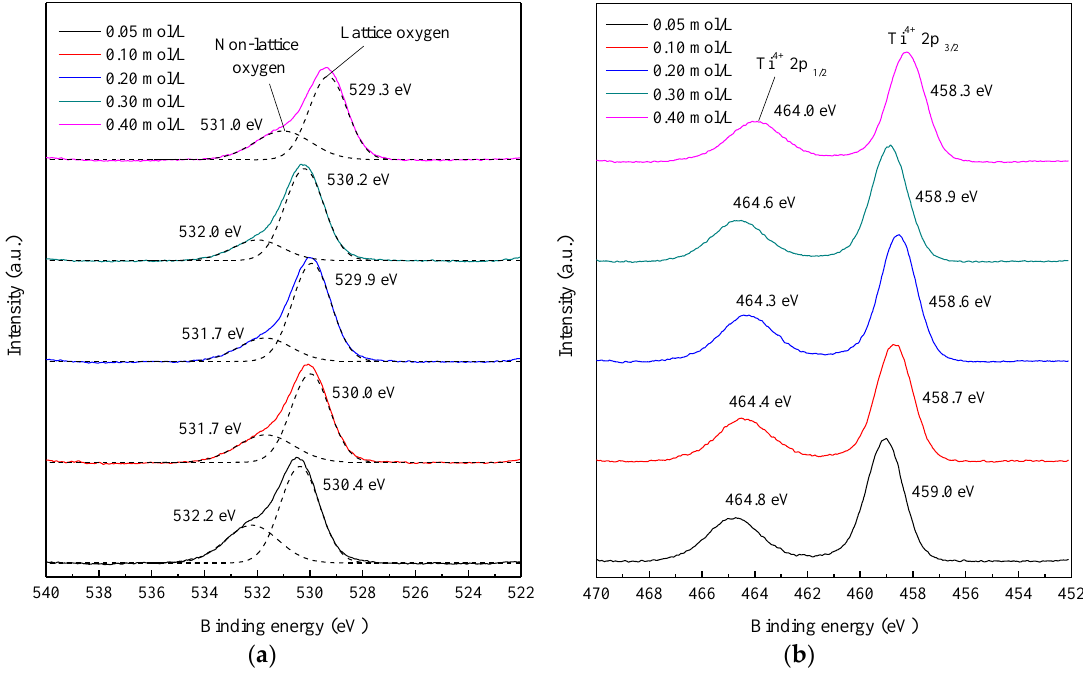
Figure 9. High-resolution XPS spectra of TiO 2 films deposited with different TTIP concentrations using the mist CVD method. (( a ) O 1s; ( b ) Ti 2p).